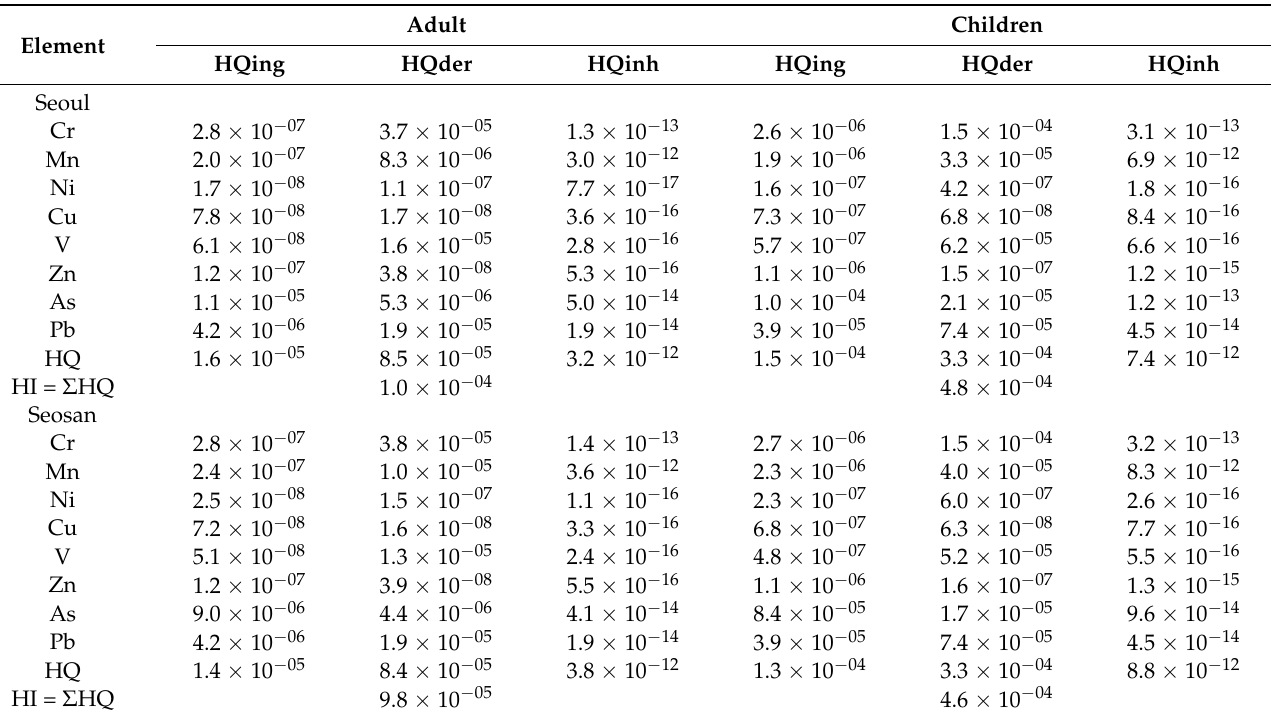
Table 4. Hazard quotient (HQ) and hazard index (HI) of components in PM 2.5 via ingestion (HQing), dermal (HQder), and inhalation (HQinh) for adults and children in rural and urban areas in South Korea during the